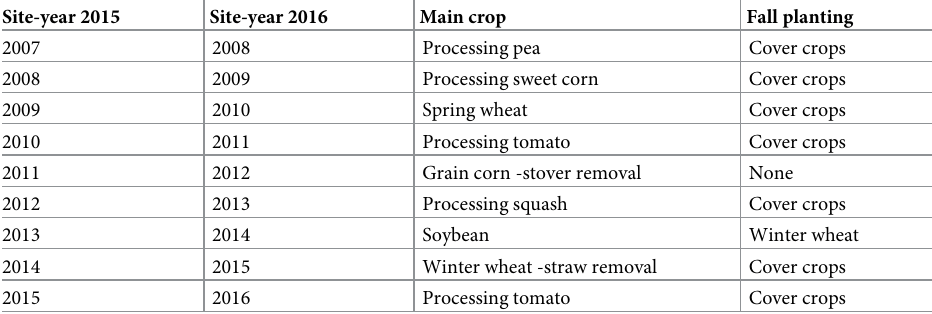
Table 2. In a medium-term cover crop experiment, crop rotation and crop residue management from 2007 to 2015 (site-year 2015) and 2008 to 2016 (site-year